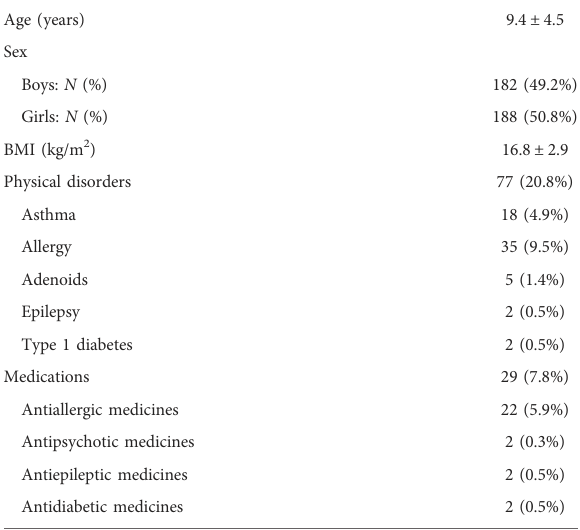
TABLE 1 Participant characteristics.